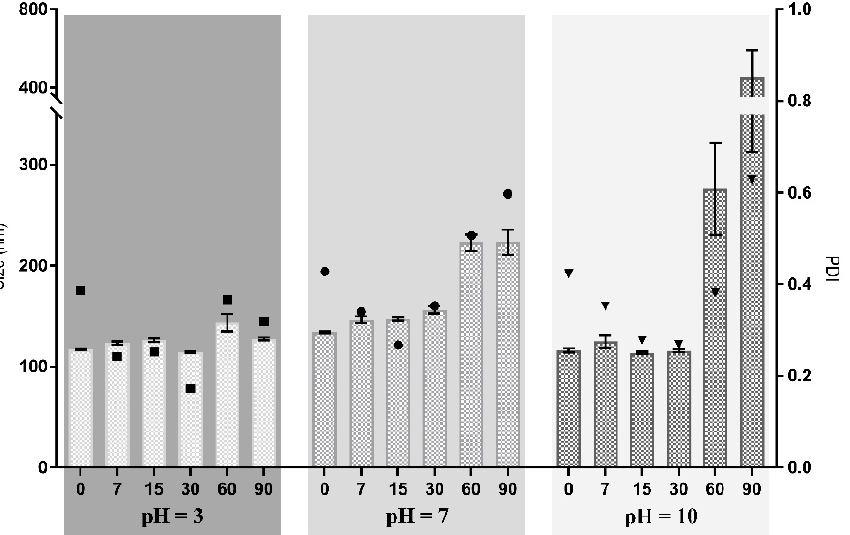
Figure 3. Stability of zein–honey–chitosan NPs in three different collecting solutions for 90 days. White bars and black squares represent the size and PDI of NPs collected in pH = 3, respectively. Light grey bars and black circles represent the size and PDI of NPs collected in pH = 7, respectively. Dark grey bars and black triangles represent the size and PDI of NPs collected in pH = 10. Data are presented as mean ± SEM ( n = 3).